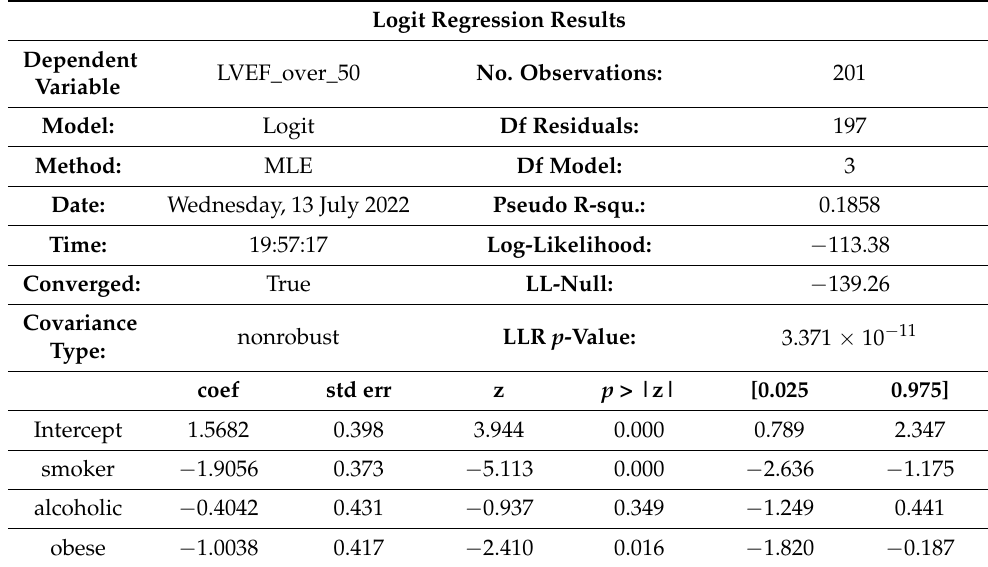
Table 3. Logistic regression output for behavioural variables. Logit Regression